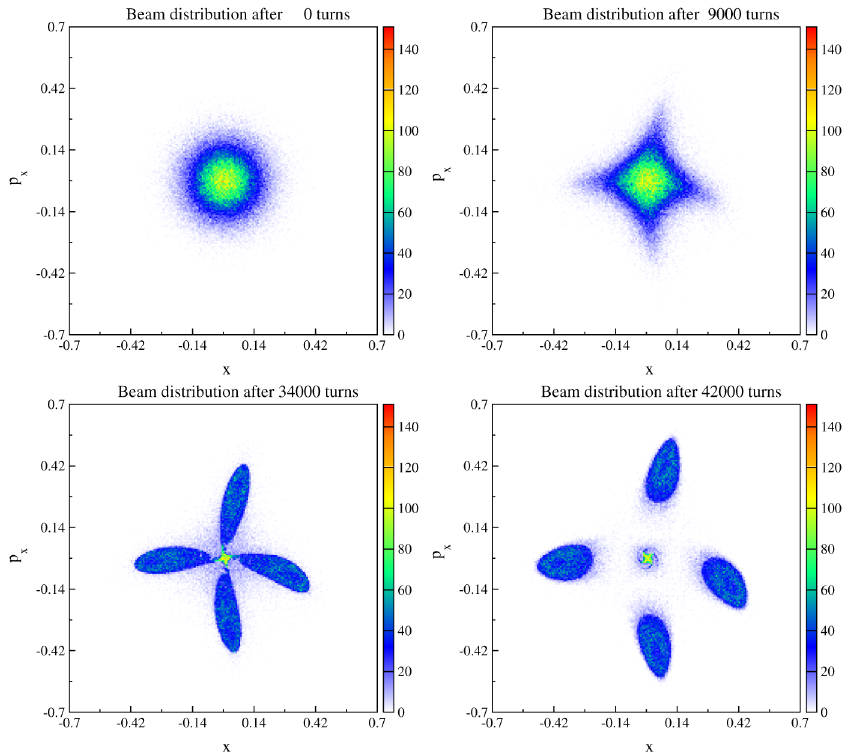
FIG. 3. (Color) Evolution of the initial distribution during the resonance crossing process.